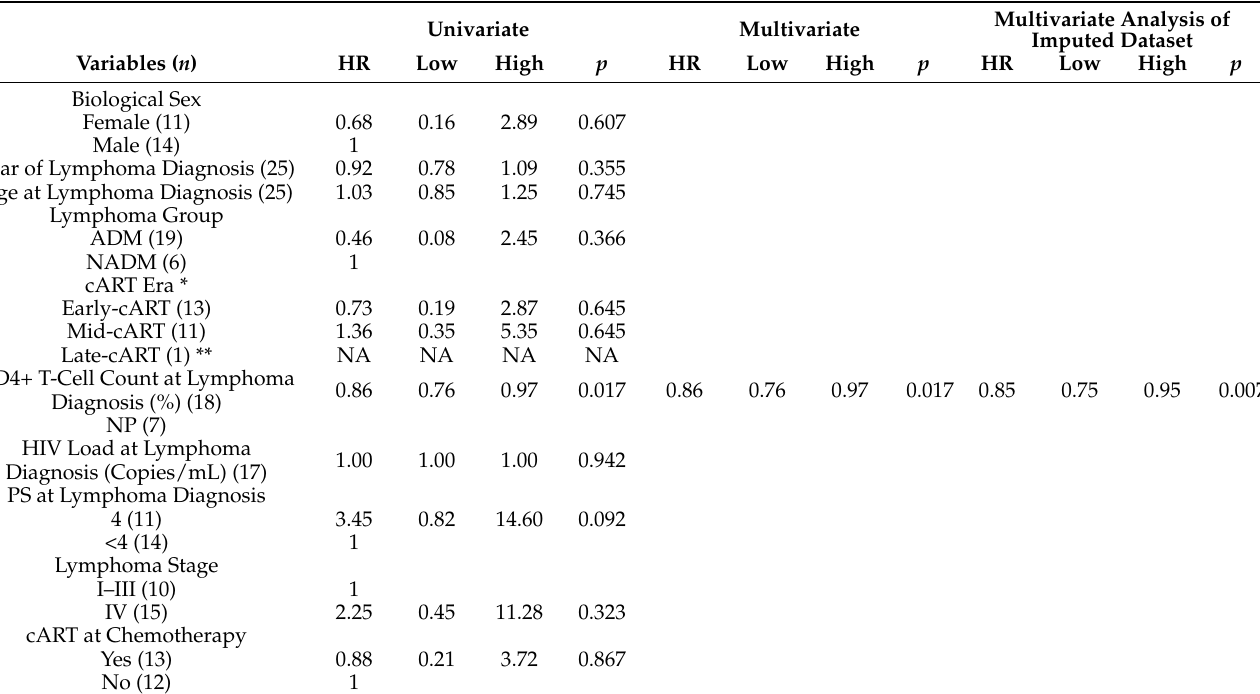
Table 4. Hazard ratio (HR) for events (DFS) (Cox proportional hazards models). Univariate Multivariate